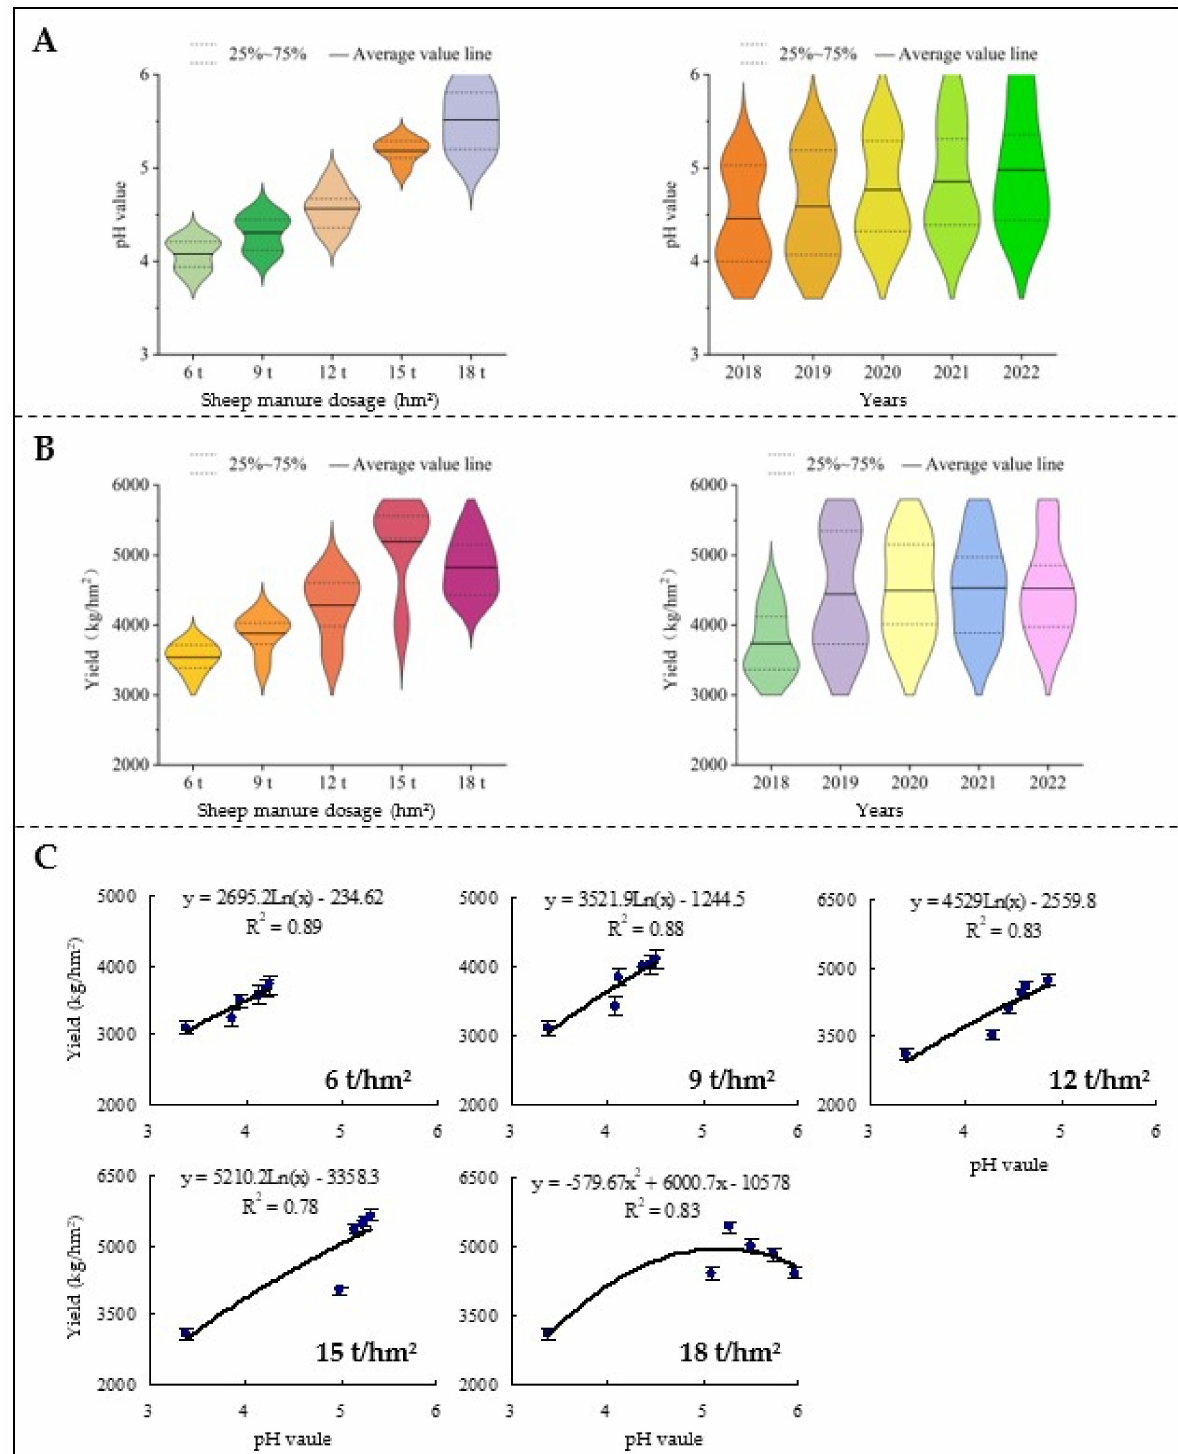
Figure 1. Effects of sheep manure fertilizer on soil pH and tea yield. ( A ) Effects of sheep manure dosage and useful year on soil pH value; ( B ) effects of sheep manure dosage and useful year on tea yield; ( C ) simulation trend analysis of the relationship between soil pH value and tea yield during 5-year application of different dosages of sheep manure